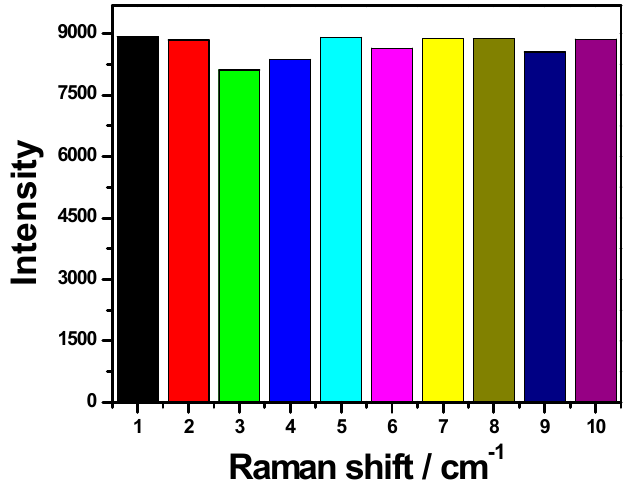
Figure 10. Reusability of MIF@GO-AgNPs substrates for Rh6G detection, measured by the changes in the intensity of the 1510 cm − 1 Raman band.